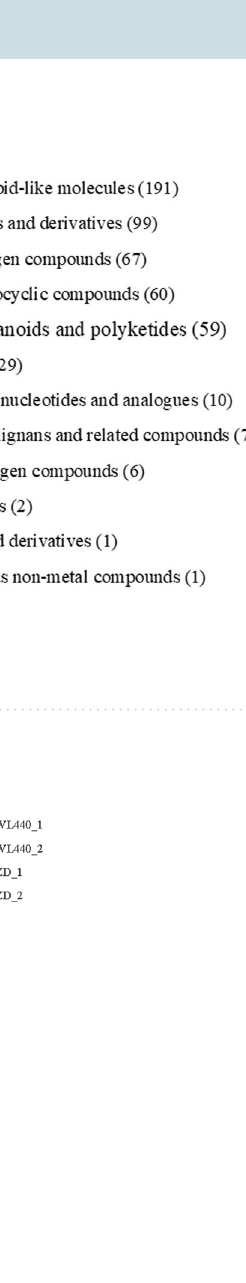
Figure 4. Principal component analysis (PCA) between different samples. The ellipse represents the 95% confidence